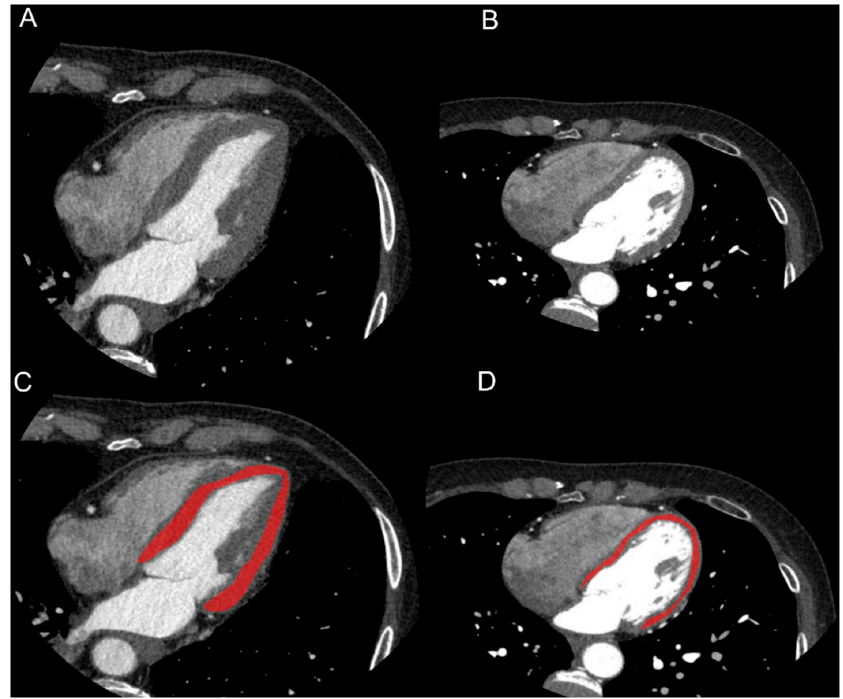
Figure 1. Images and segmentation examples of cardiac CTs of patient with history of hypertension (HTN, ( A – C )) and without history of hypertension (NC, ( B – D )). On a 4-chamber view, LV was segmented using a polygonal region of interest (ROI). Care was taken in not including blood in LV cavity, epicardial fat or major coronary arteries. Clinical data of HTN patient were: male, 73 years old, BMI = 24.7 kg/m 2 , history of diabetes, dyslipidemia and hypertension, septum width: 14 mm. Clinical data of NC patient were: female, 61 years old, BMI = 18.9 kg/m 2 , smoker, familiarity with cardiovascular disease, no history of diabetes, dyslipidemia and hypertension, septum width: 8 mm. Gray-level normalization was performed by rescaling the histogram data within μ - gray-level mean ±3 σ ( σ -gray-level standard deviation) to reduce contrast and brightness variations that might impair texture feature quantification [10].